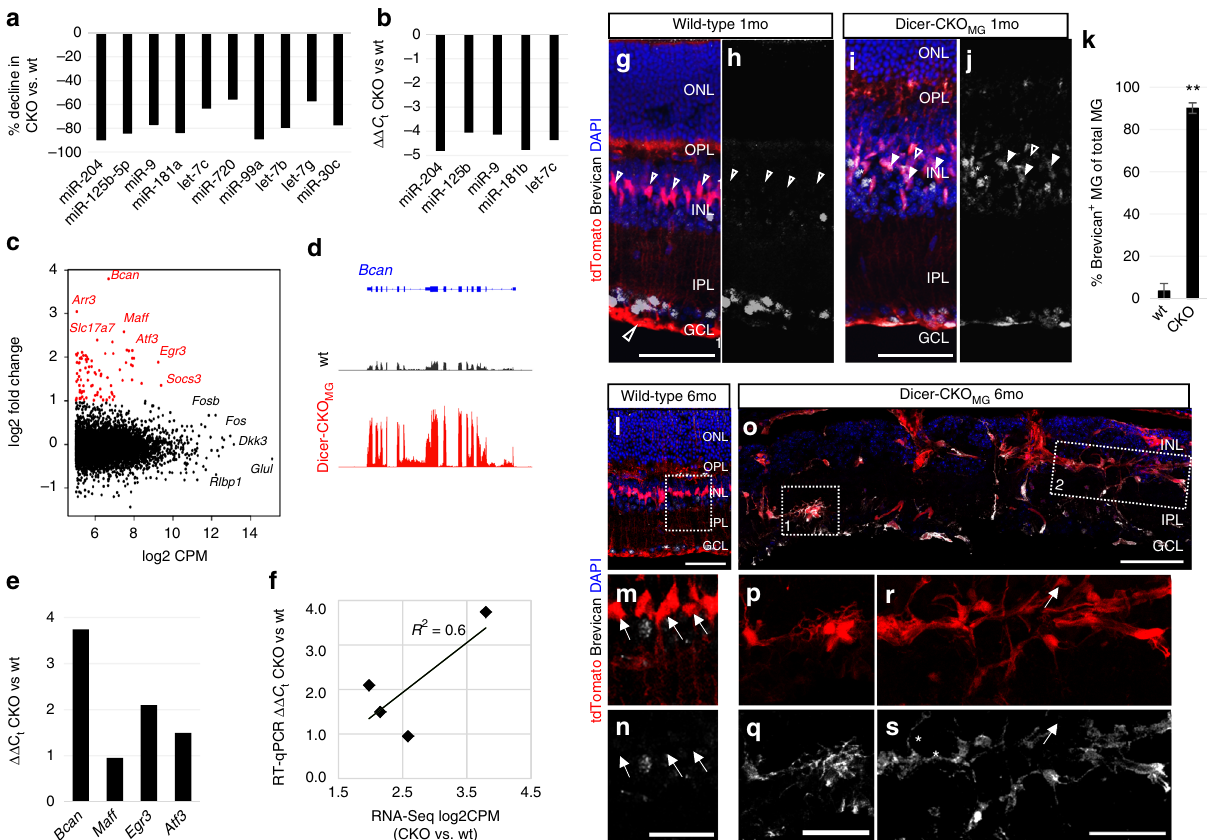
Fig. 4 Dicer-CKO Müller glia express Brevican, which leads to disorganization. a Percent decline of the top 10 highly expressed MG miRNAs in the Dicer- CKO MG , listed in order of their highest expression levels, retinas of 40 wt and 26 CKO retinas were pooled. b RT-qPCR comparison of the top fi ve highly expressed miRNAs for Nanostring validation (40 wt and 26 CKO retinas). c Scatter plot of genes differently regulated in the MG from Dicer-CKO MG compared with MG from wt, shown as log2 of fold change and of counts per million (CPM). Genes showing the greatest increase are highlighted in red. d Bcan gene model (top) with the mapped reads from RNA-Seq in the wt and the Dicer-CKO fi rmation of the top four genes upregulated in MG . e RT-qPCR con RNA-Seq in the Dicer-CKO MG (26 retinas, pooled) when compared to wt MG (32 retinas, pooled). f Comparison of ΔΔ C t means CKO vs. wt from RT-pPCR of four highly expressed genes in the Dicer-CKO MG from FAC-sorted MG (26 CKO and 32 wt retinas pooled, normalized against beta-actin) vs. log2 CPM from RNA-Seq, regression coef fi cient R 2 = 0.6. g – s Immuno fl uorescent labeling for tdTomato, Brevican, and DAPI. g – j 1 month after deletion: in wt mice, Brevican was expressed in neurons (asterisks) in the GCL and INL but not in MG (neither somata nor endfeet, un fi lled arrows, g , h ). Most MG in Dicer- CKO MG mice expressed Brevican, i , j , in their endfeet in the GCL and in their somata in the INL ( fi lled arrows). Un fi lled arrows point to rare MG without Brevican. k Percentage of MG expressing Brevican in wt ( n = 7) and MG from Dicer-CKO MG mice ( n = 7, mice of at least two different litters were analyzed). l – s 6 months after deletion: while the wt remains unchanged ( l – n ), tdTomato + Brevican + MG in the Dicer-CKO MG form aggregates in the IPL/ GCL ( o – q ) and INL/ONL ( o , r , s ). Statistics: mean ± S.D., Shapiro – Wilk test for normality and Mann – Whitney U -test, signi fi cant differences: ** p <